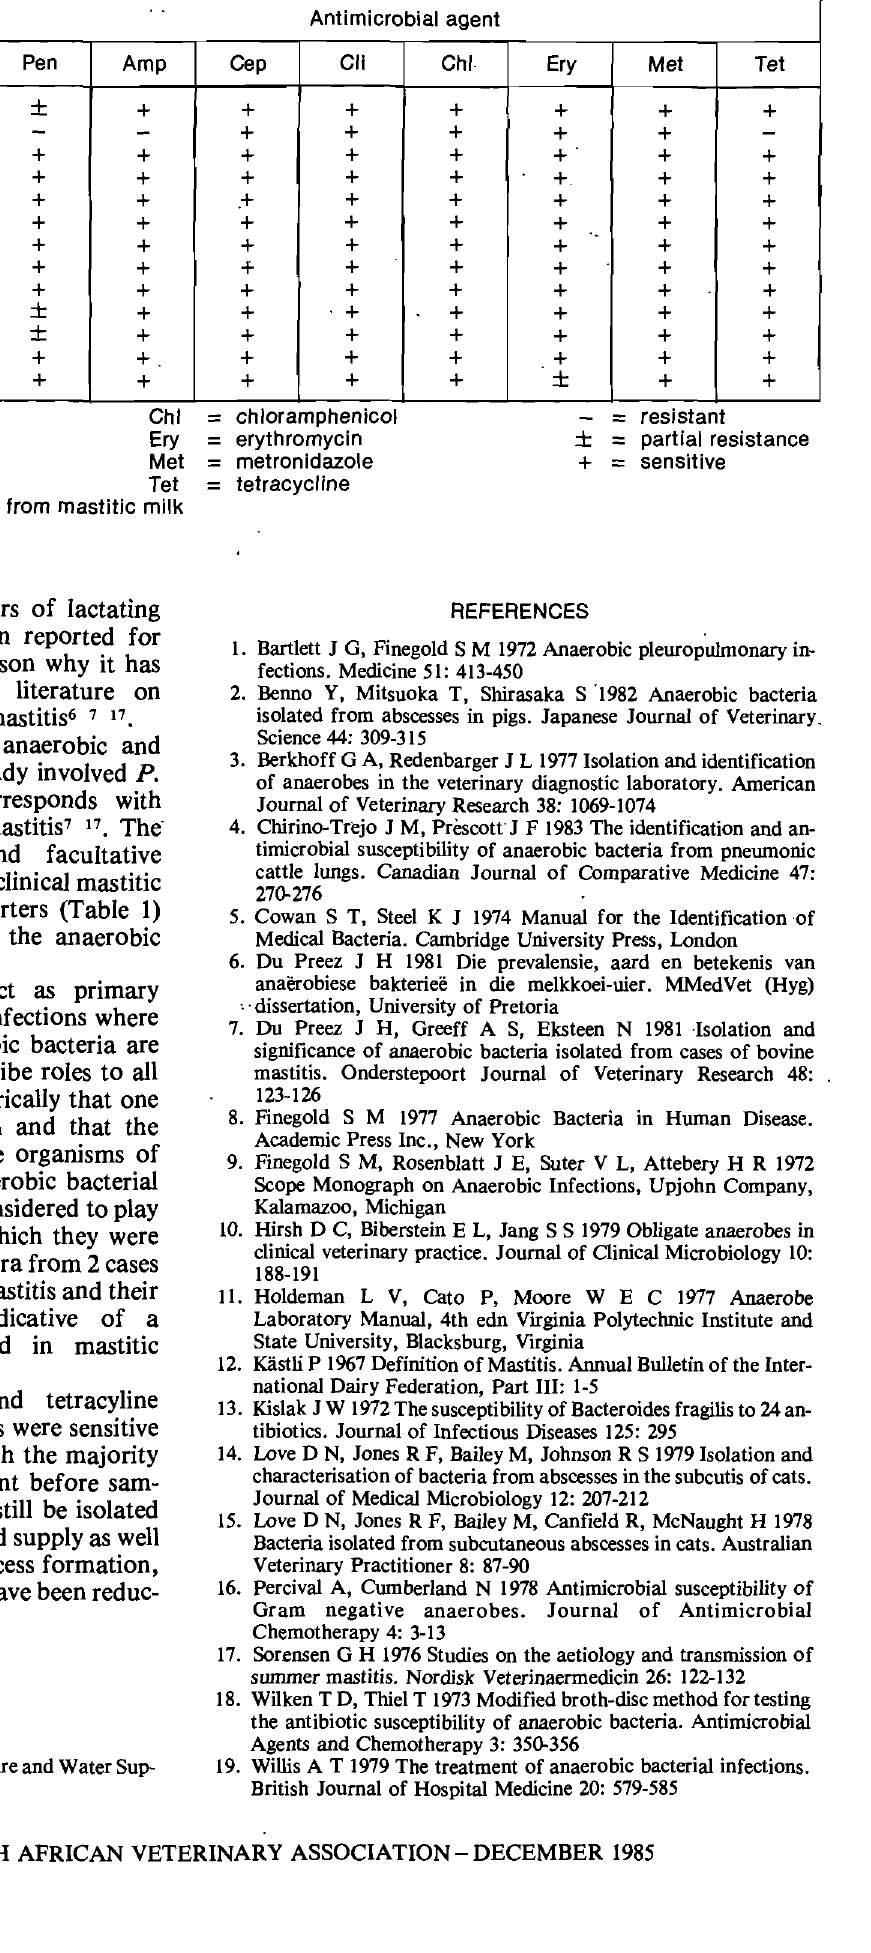
Table 2: Antimicrobial sensitivity of some anaerobic bacterial isolates from cases of udder abscesses Anaerobe Cow No. Pen Amp